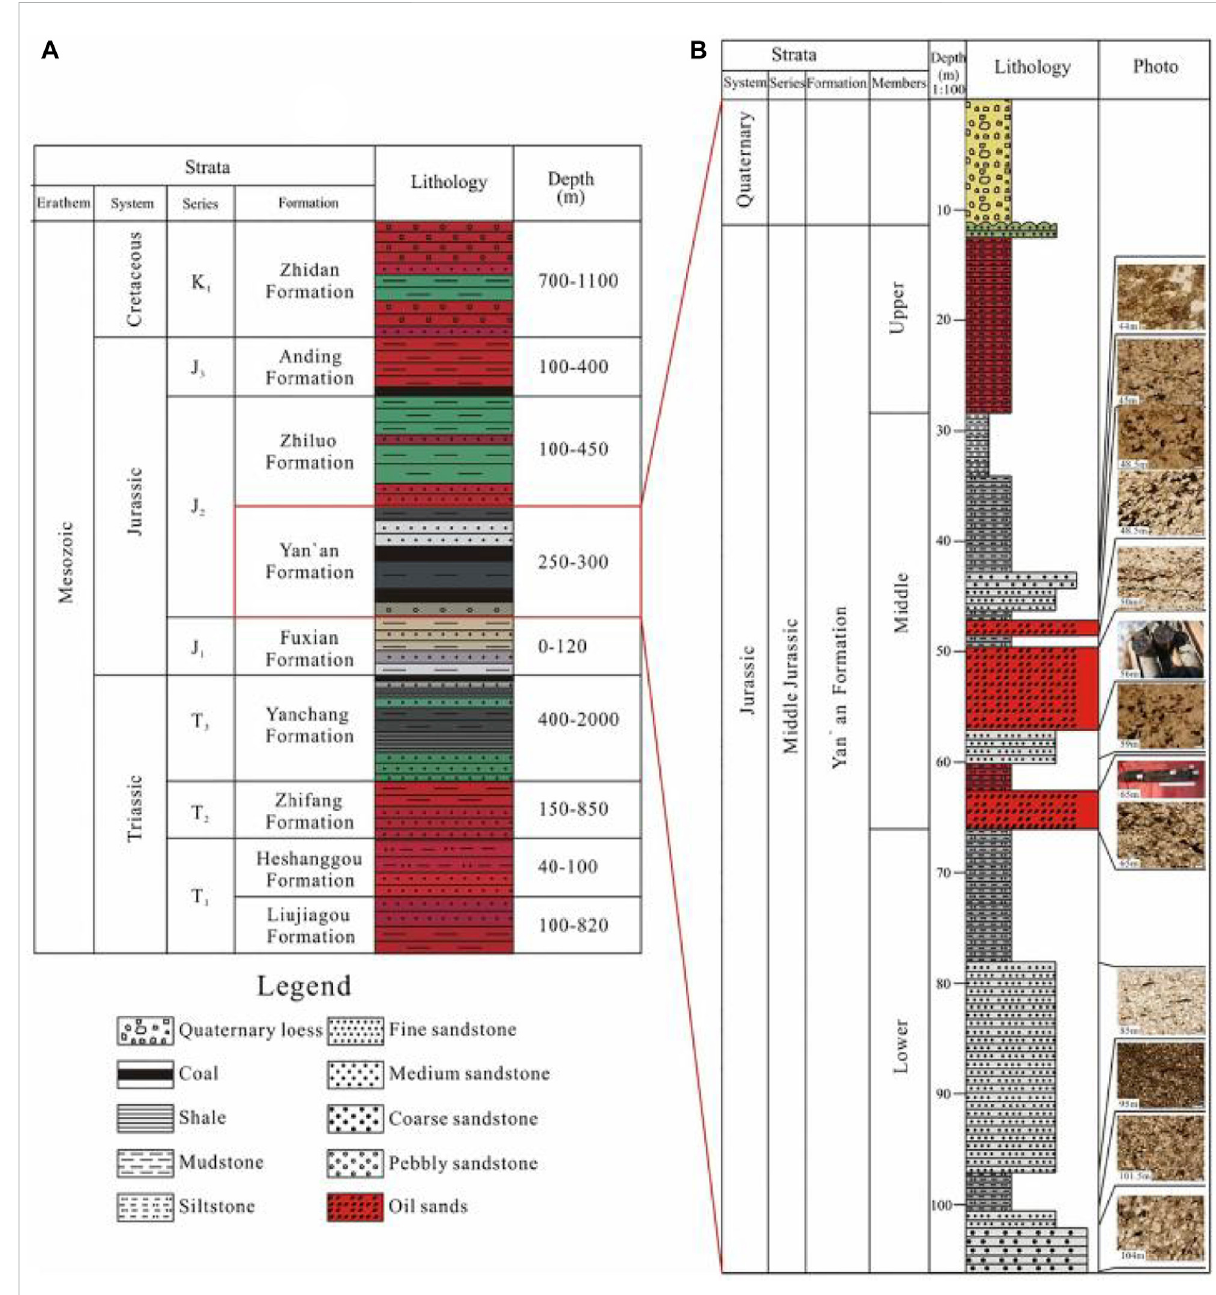
FIGURE 2 Division of stratigraphic units of the Jurassic strata in the Ordos Basin (Ji et al., 2014). Notes: (A) Stratigraphic units in Mesozoic strata; (B) Lithologic pro fi le in Well Weisha 2.